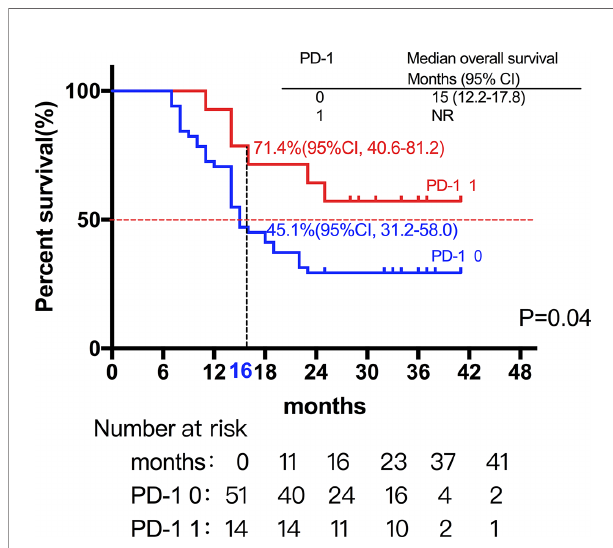
FIGURE 7 | A total of 14 patients had the opportunity to continue the treatment of PD-1 antibody after PD, and the prognosis was not surprisingly